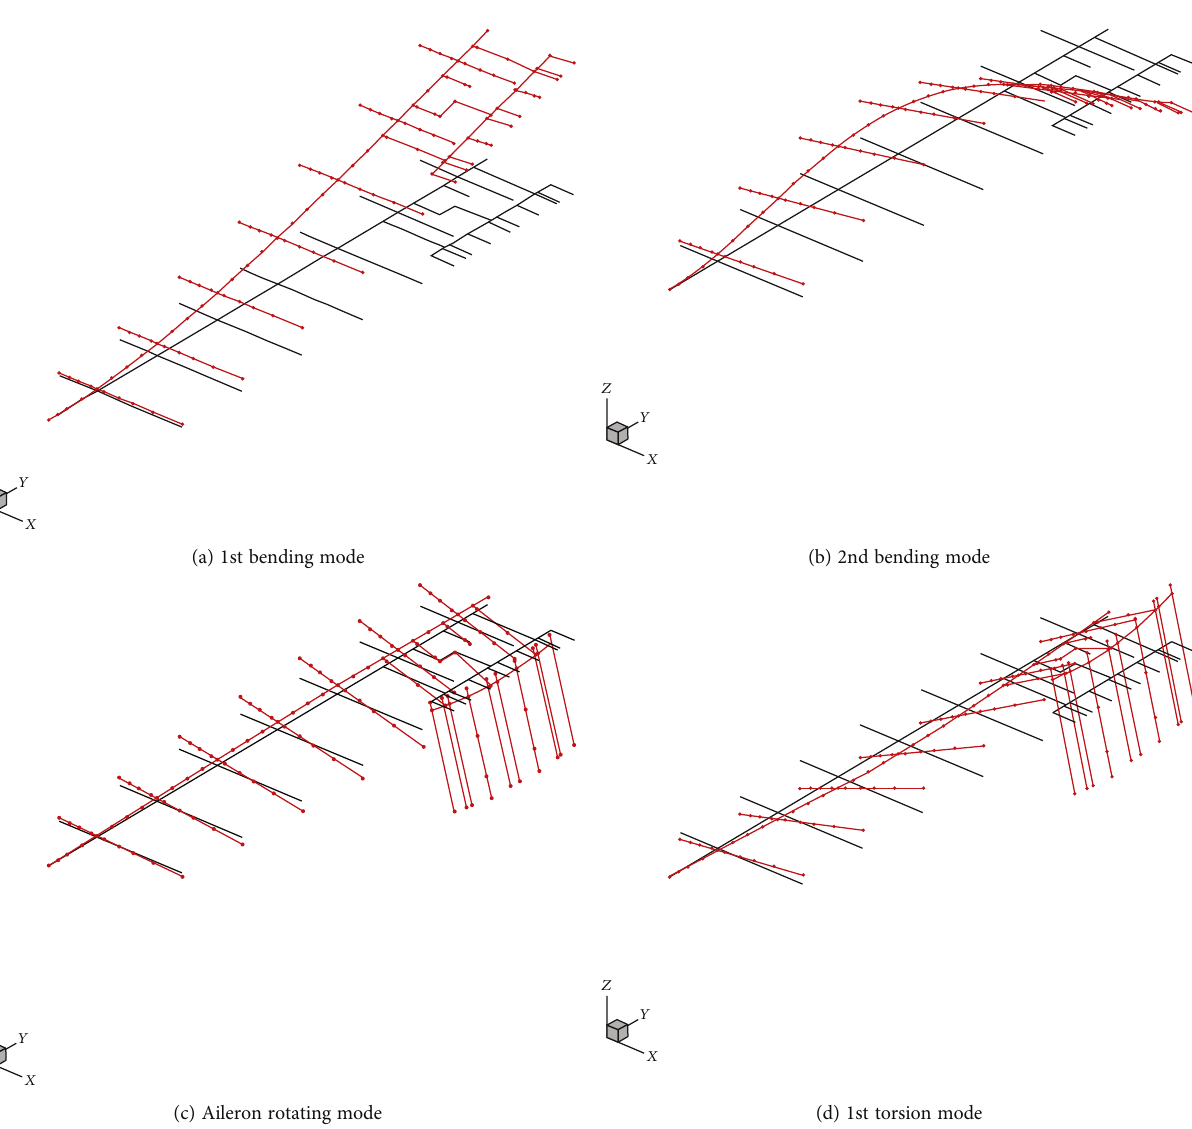
Figure 14: First four mode shapes of the linear FE